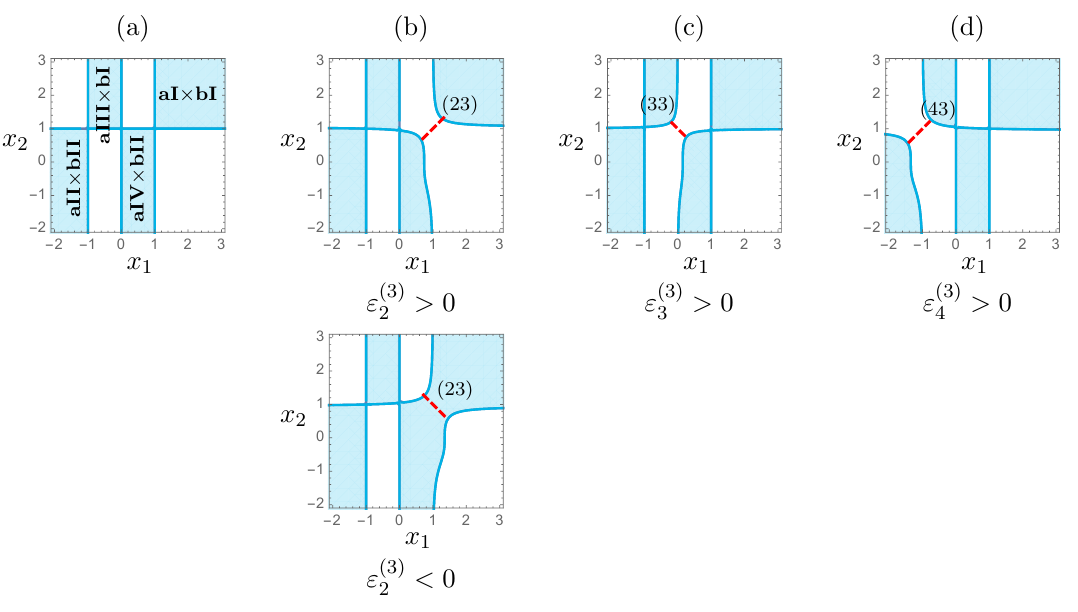
Figure 11 . Hypersurface equation (2.20) in the ( R -projected) ( x 1 ; x 2 ) plane for various Z (3) formation parameters: all deformations are set to zero in (a); j " (3) (23) in (b); " (3) = 0 : 05 deforms the singularity (33) in (c); " (3) 3 in (d). The contour lines correspond to zeros of y , while the blue-coloured regions represent sLag two-cycles calibrated with respect to Re((cid:10) 2 ). The exceptional cycles with non-zero volume arising at the deformed singularities are indicated by a red dashed